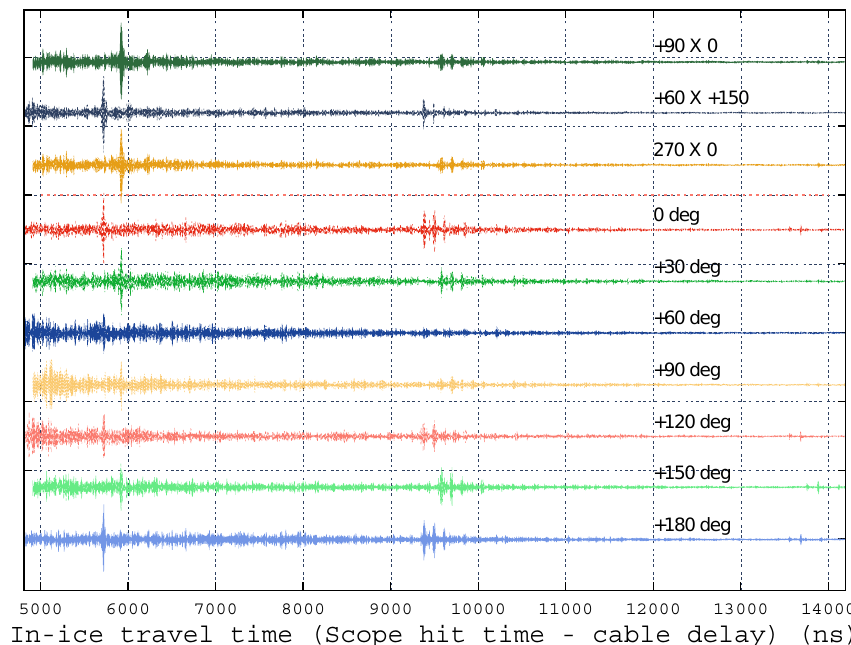
Fig. 3. Ensemble of echo amplitudes observed as a function of azimuthal orientation, for both co-polarized and cross-polarized broadcast signals, for echo times between 5µs and 14µs. A DC offset has been added vertically to successive voltage traces for visual clarity; alternate waveforms are similarly also offset by ± 100 ns along horizontal. Each division vertically corresponds to